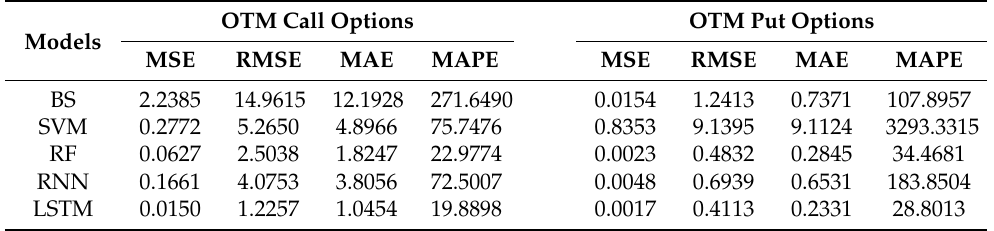
Table 10. Pricing error of OTM options estimated using different models when using realized skewness. Models